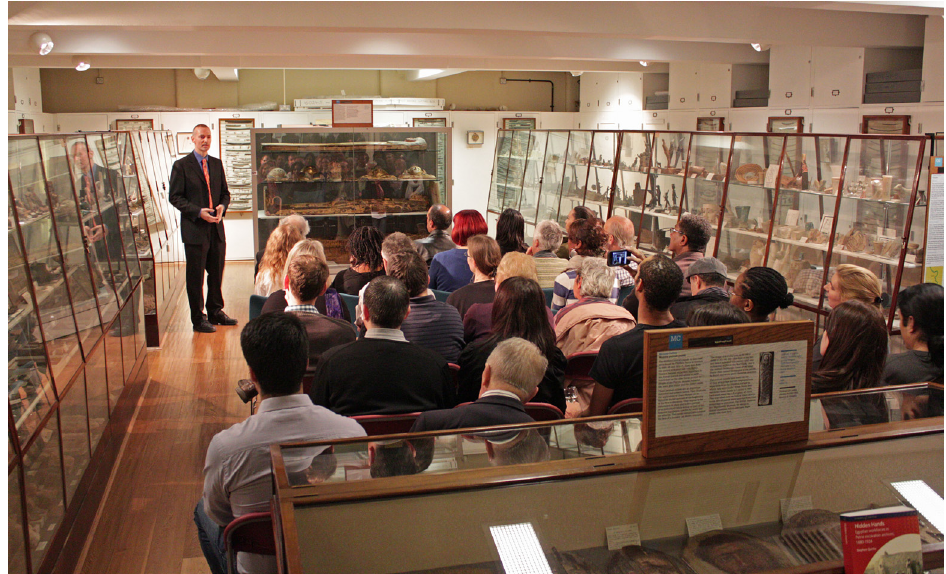
Fig. 3: The multi-purpose space in the Petrie Museum, surrounded by object displays,